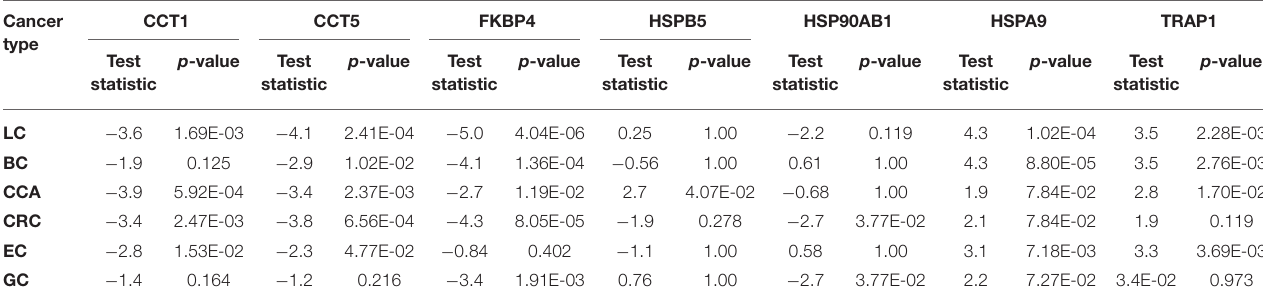
TABLE 1 | Differentially expressed HSPs and cochaperones in the urine of the cancer patients compared to healthy volunteers by Dunn’s test with Holm–Bonferroni correction. Cancer